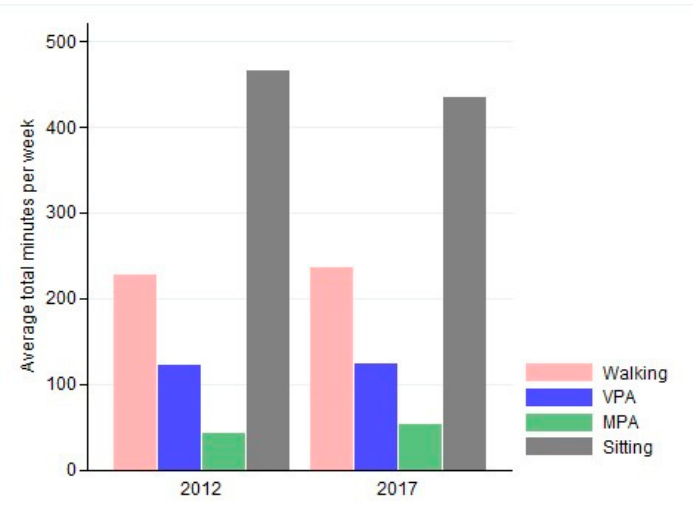
Figure 1: Average weekly minutes of physical activity and sitting time in 2012 and 2017. Walking: minutes of walking in bouts of at least 10 min; VPA: Vigorous physical activity; MPA: Moderate physical activity.